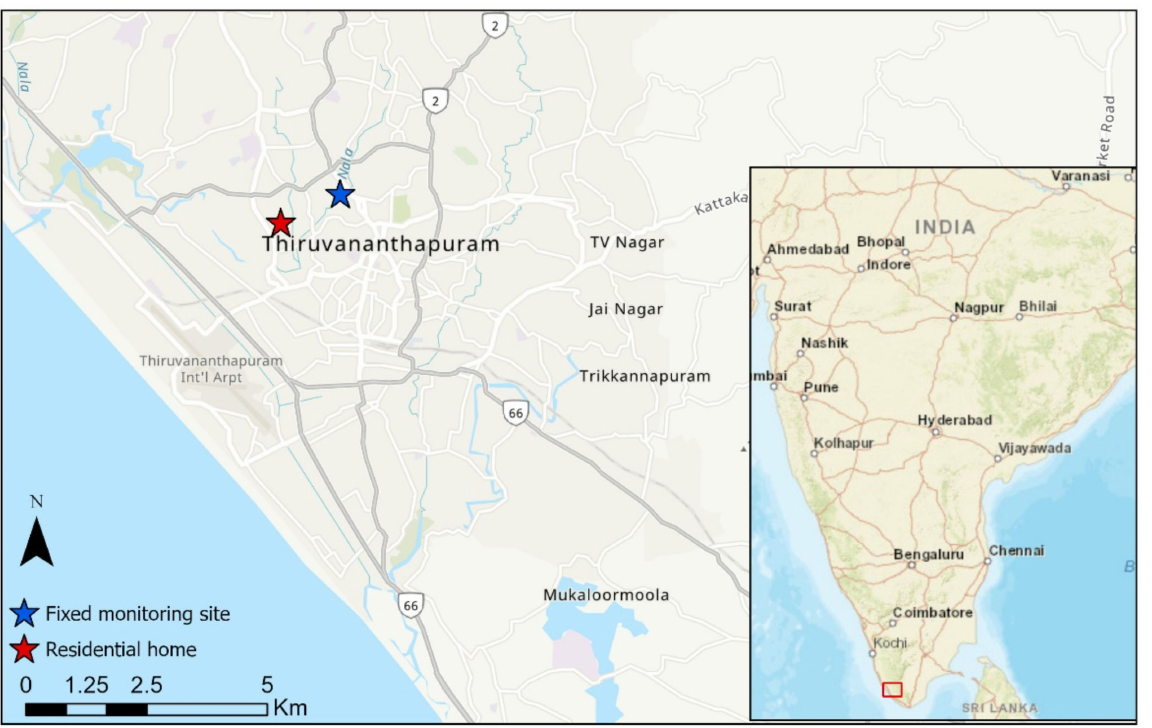
Figure 1. Map view highlighting Trivandrum; the red star highlights the residential home, whereas the blue star shows the location of the fixed monitoring site (2.1 km from the residential home), and (inset) overview of